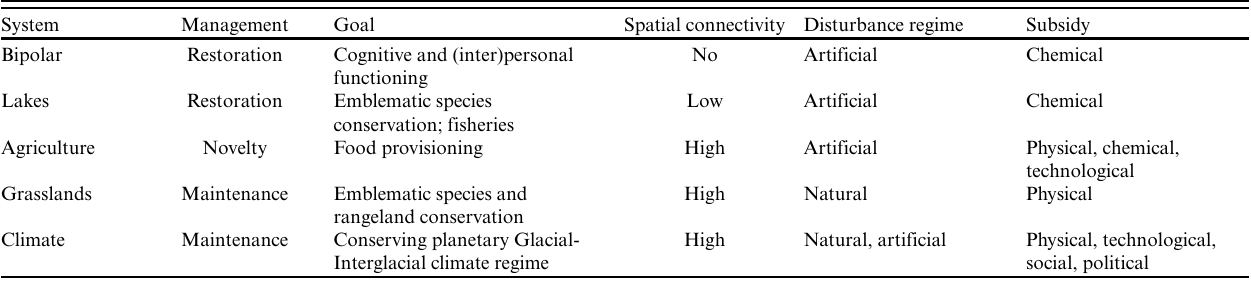
Table 2 . Comparison of coerced-resilience